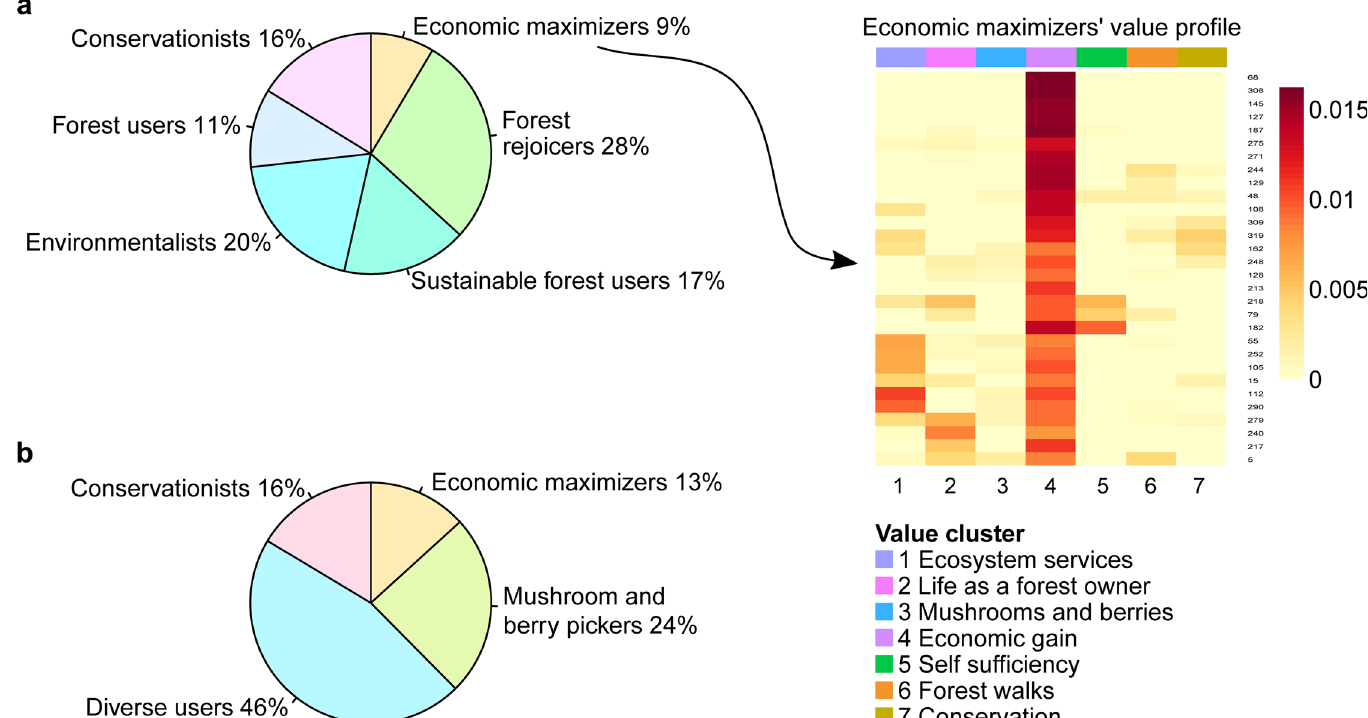
Fig 2. Value profiles and percentage of respondents by country. Value profiles for identified groups in Sweden (a) and Germany (b) based on individual respondents ’ preference loadings (S2 Fig) on all value clusters identified in each country (S1 Fig). Inserted example shows loadings on value clusters for the 30 Swedish respondents with an "Economic maximizer" value profile.